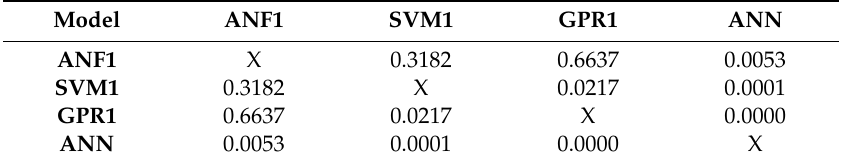
Figure 15. Results of testing chosen models with experimental input from supplementary S8 of [15]: ( a ) time plot of the applied force; ( b ) time plots of the ISF obtain from different models.